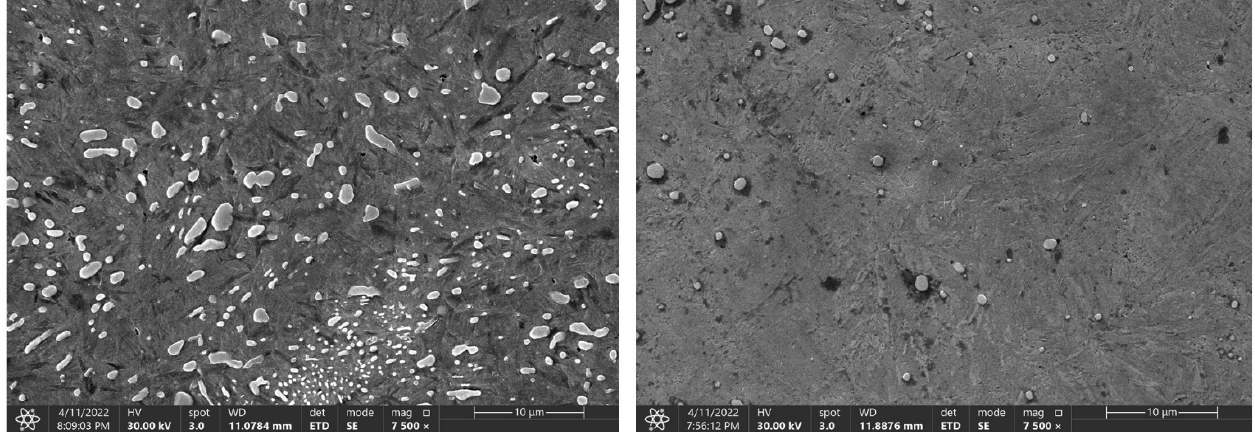
Figure 11. Change in the microstructure of the C105W1 steel, with a heating time of 140 s and 3600 s.